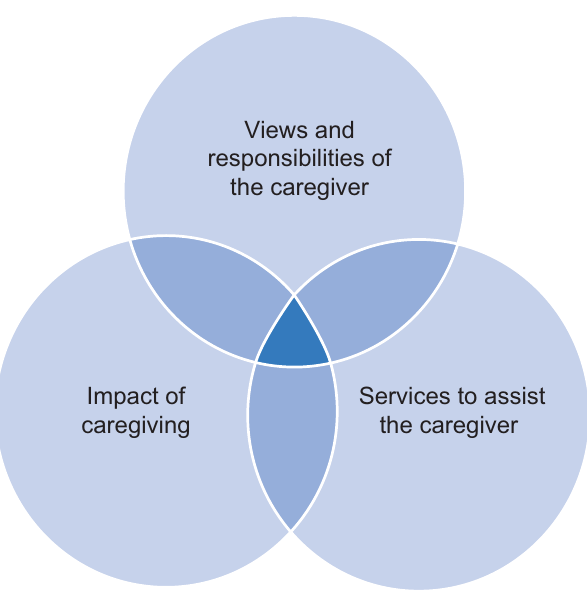
Figure 1: Main themes of